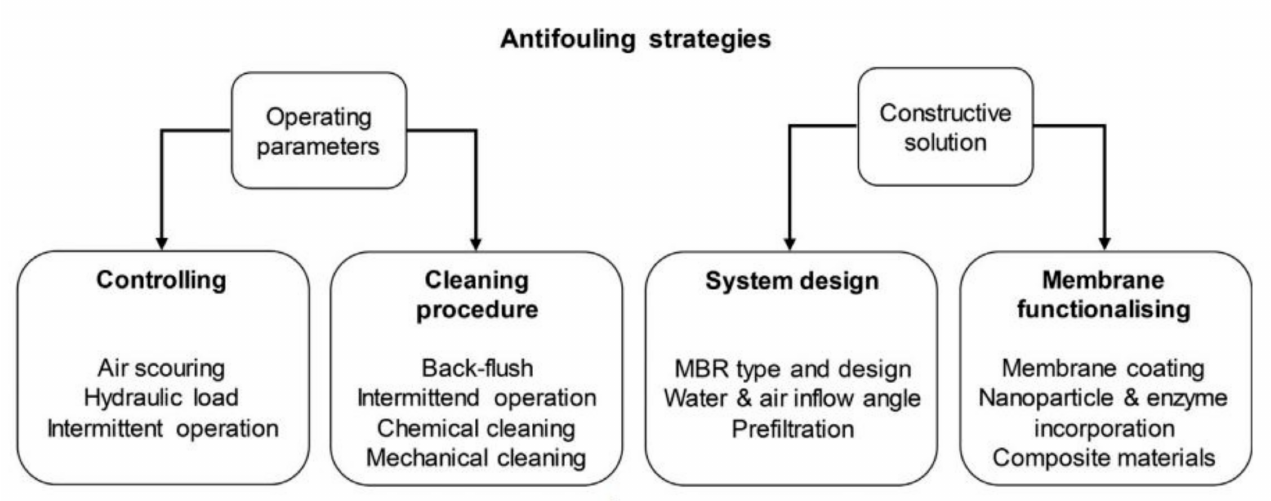
Figure 7. Antifouling strategies adapted from [136].